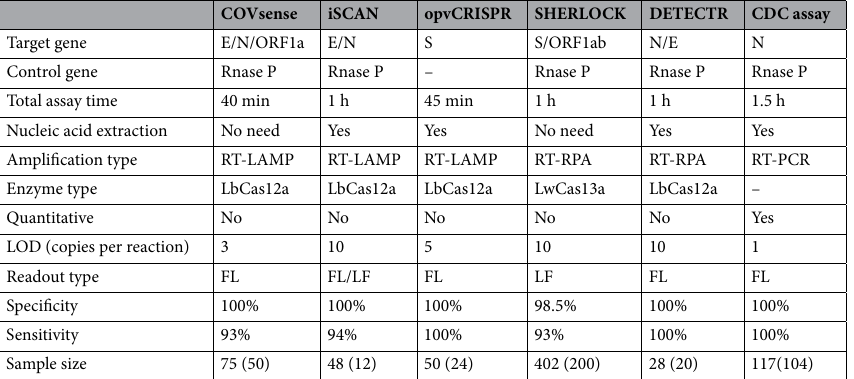
Table 1. Comparison between different CRISPR/Cas based diagnostic methods. COVsense (this study); iSCAN 15 ; opvCRISPR 16 ; SHERLOCK 26 ; DETECTR 17 ; CDC Assay 27 . () indicate negative samples . E envelope protein gene, N nucleocapsid protein gene, ORF1a open reading frame 1a gene, S spike protein gene. RT reverse transcription, LAMP loop mediated isothermal amplification, RPA recombinase polymerase amplification, PCR polymerase chain reaction. FL fluorescence, LF lateral